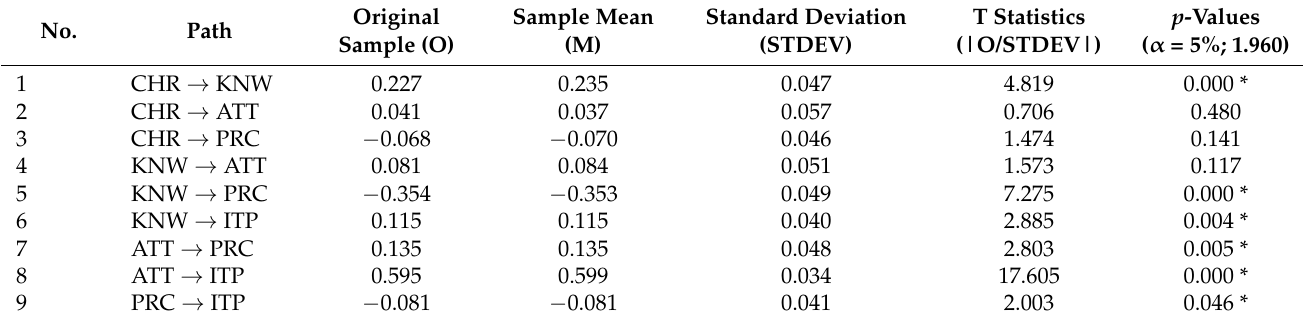
Table 7. Path Analysis and Bootstrapping Student’s t